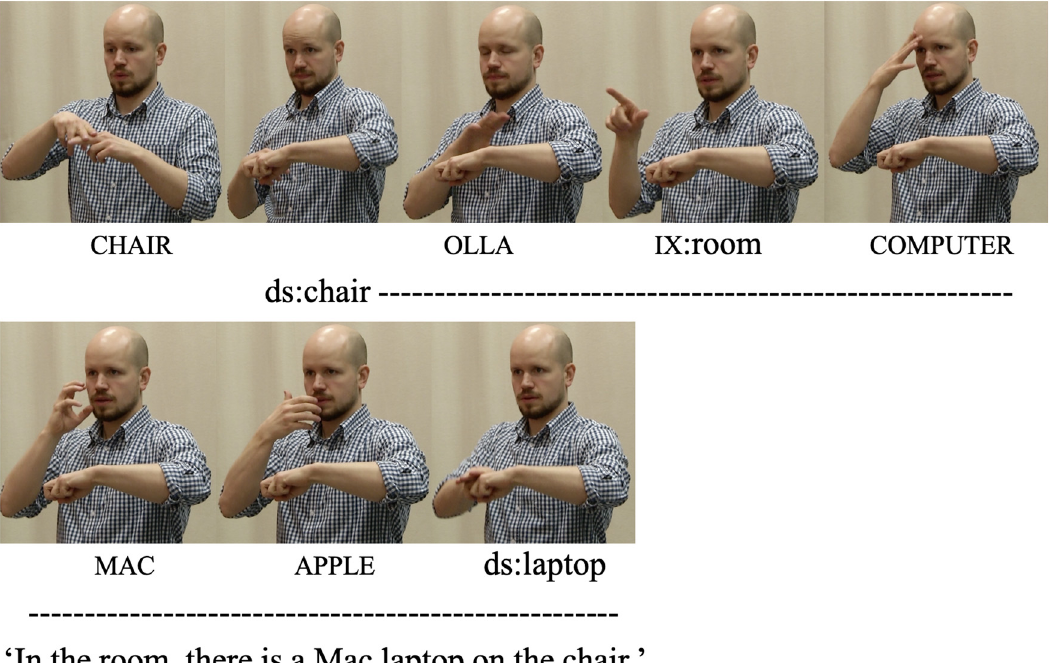
Figure 9: An example of the simultaneous production of Ground and